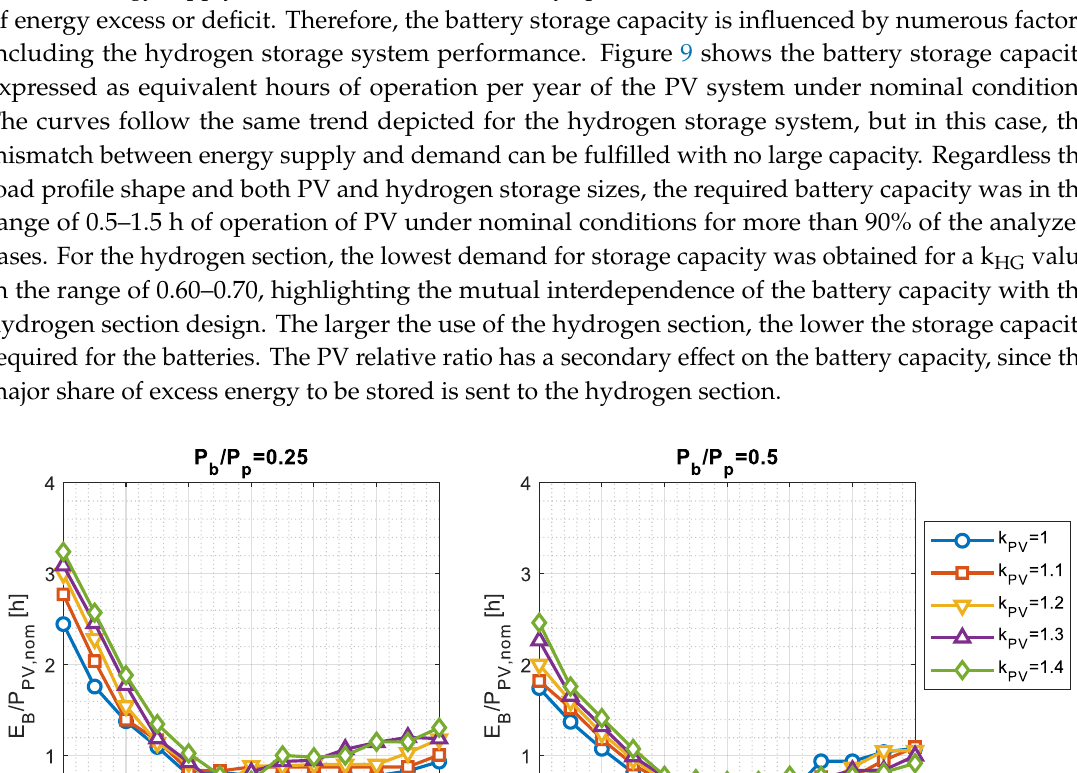
Figure 10. Hydrogen-based plant self-sufficiency ratio as a function of k HG and different k PV values for ( a ) P b /P p = 0.25 and ( b ) P b /P p = 0.5. 4. Preliminarily Economic Analysis The previous section showed how a hydrogen-based energy storage system operates in PV microgrids supplying facilities with low demand during weekends (like in public, commercial, and SME buildings). The following preliminary economic analysis investigated in which conditions the proposed plant can become cost effective for medium-sized photovoltaic plants with nominal power in the range 200–1000 kW p and a peak load of 100–500 kW, in which the produced energy is only partially exploited during the weekend to fulfill the base load (no peak loads are present). The